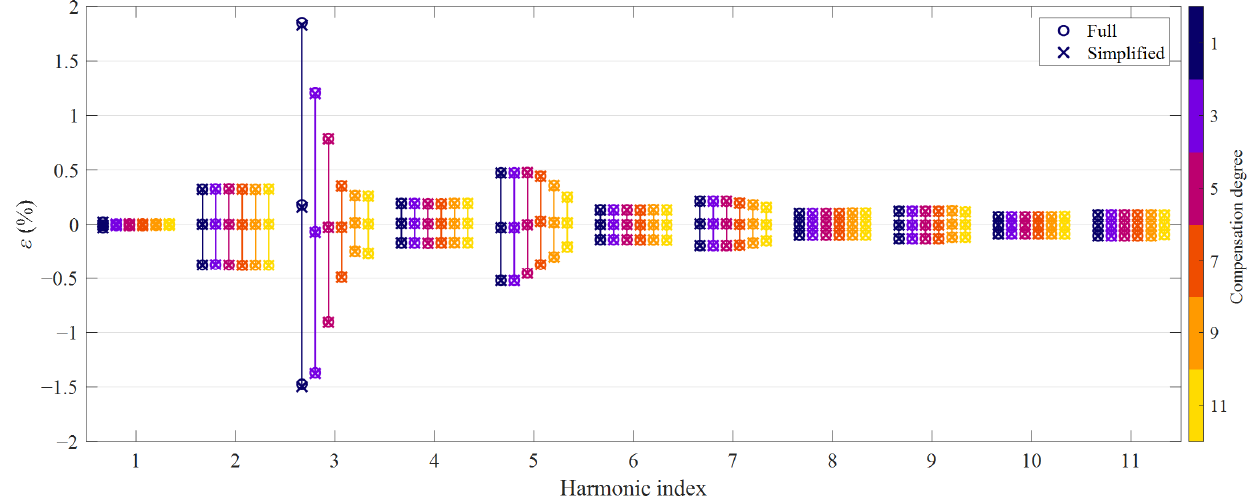
Figure 3. Ratio error achieved with the proposed HD compensation methods: odd degrees from 1 to 11, average values and 95th percentile bands (numerical simulations).